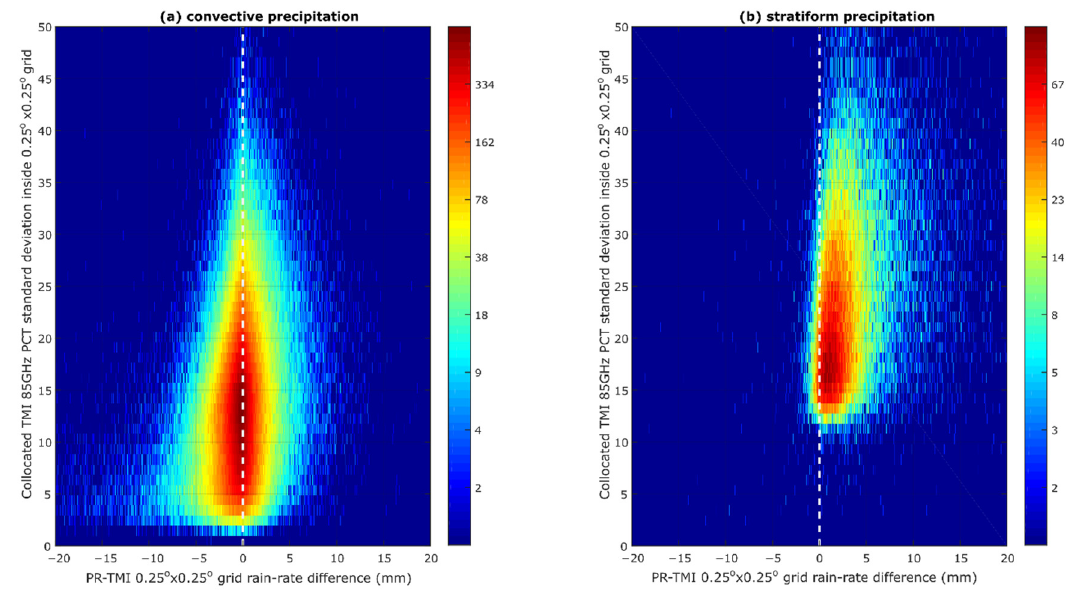
Figure 7. Joint frequency histogram of the gridded rain-rate estimation difference between PR and TMI regarding the standard deviation of TMI 85 GHz PCT at the same grids for ( a ) deep convective precipitation and ( b ) deep stratiform precipitation. (Source: data processing).